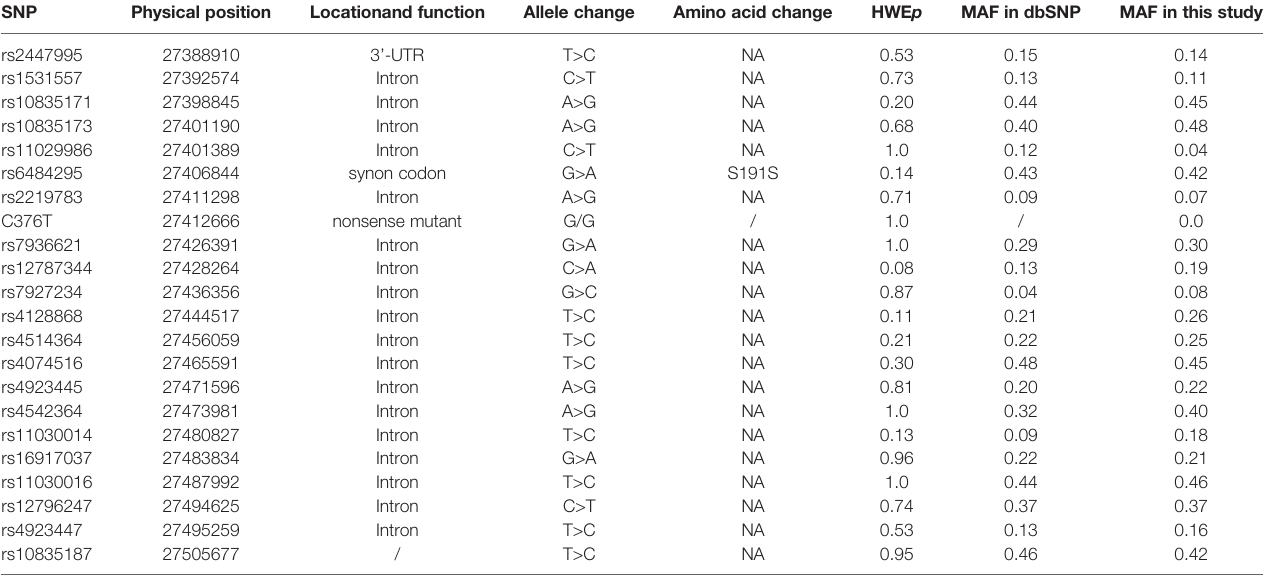
TABLE 2 | Information of the analyzed LGR4 SNPs in this study.